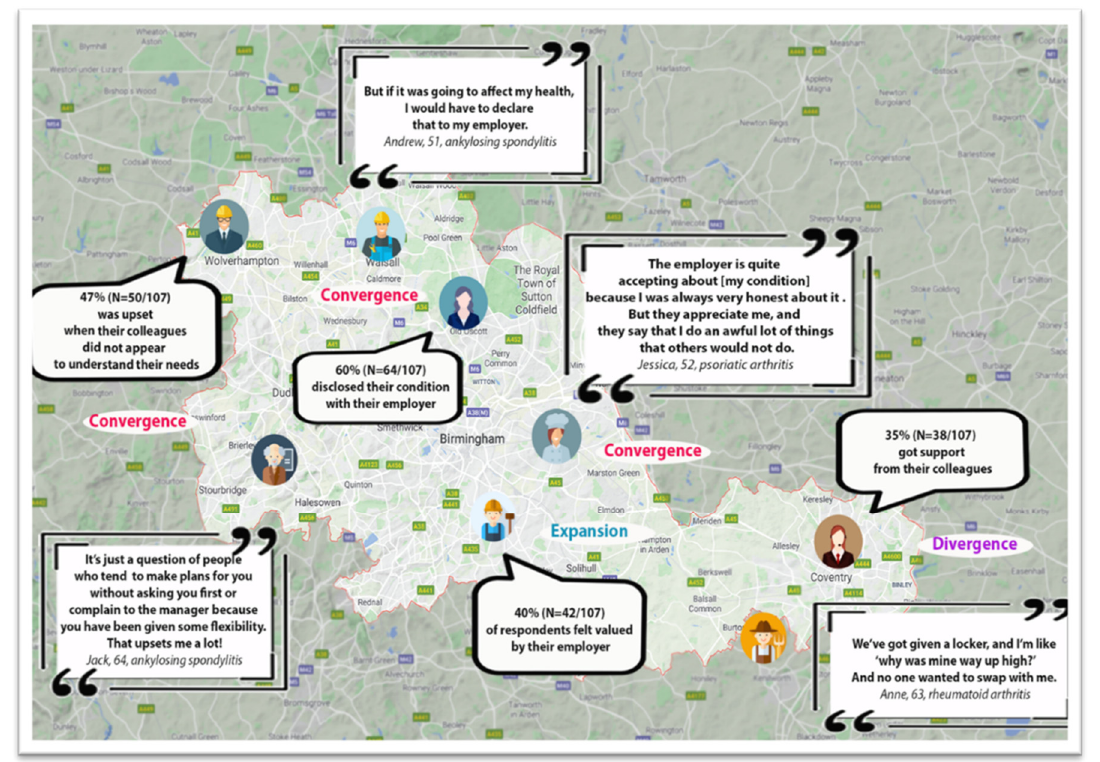
Figure 5. A visual joint display of the integrated findings related to the theme “social support and disclosure”. Note: graphics were used to represent employment roles discussed by the study participants, and the related survey findings and examples of illustrative qualitative quotes are presented in bubbles.